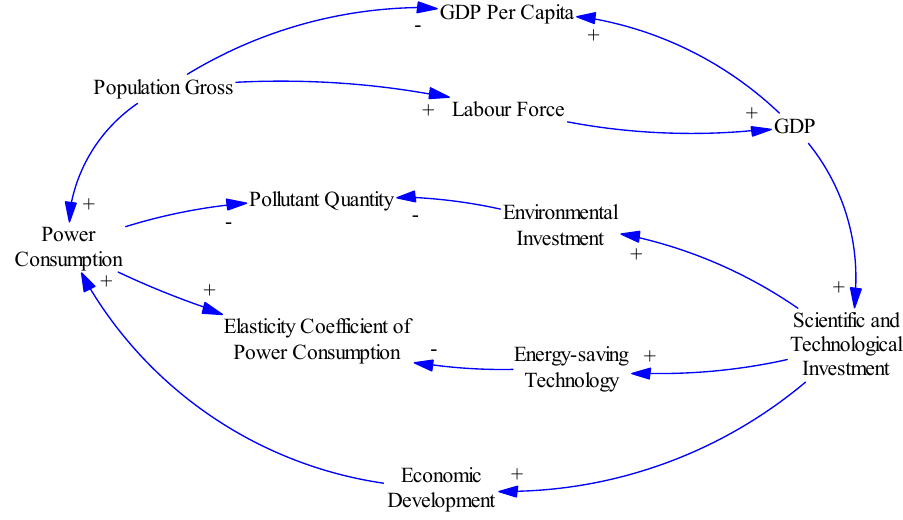
Figure 6. Causal feedback diagram of elements of the power supply and demand system.